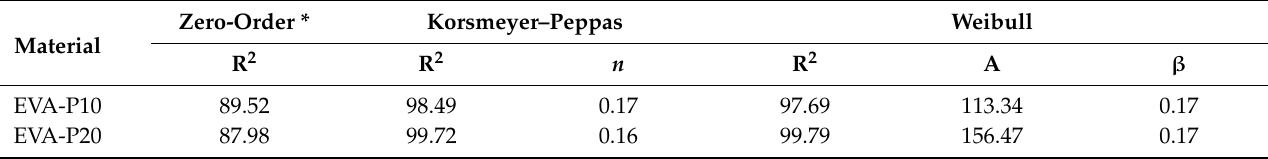
Table 4. Drug release parameters of EVA/ACV samples fitted by mathematical kinetic models.